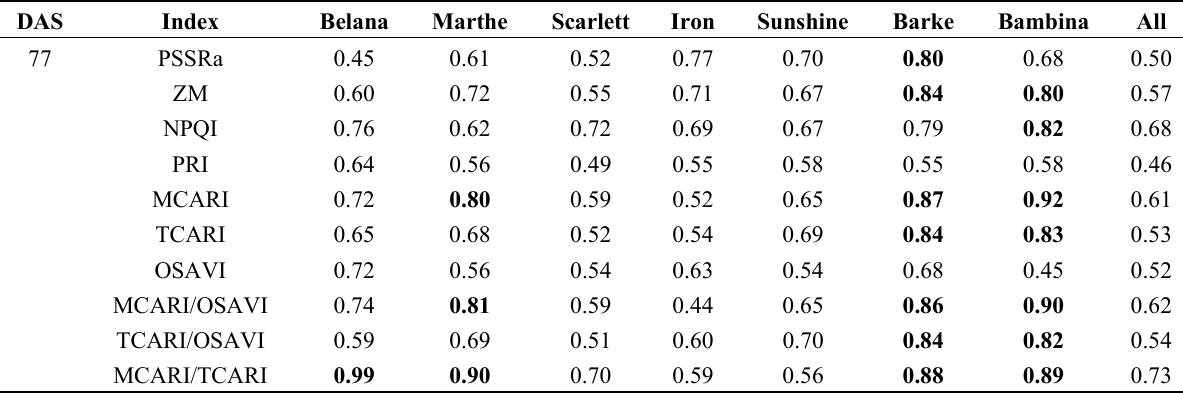
Table 5. The c statistic showing the performance of hyperspectral indices in discriminating between the with- and without-fungicide treatments (bold font and italics highlight c -values that are not less than 0.8 for each variety and for all varieties, respectively). DAS Index Belana Marthe Scarlett Iron Sunshine Barke Bambina All